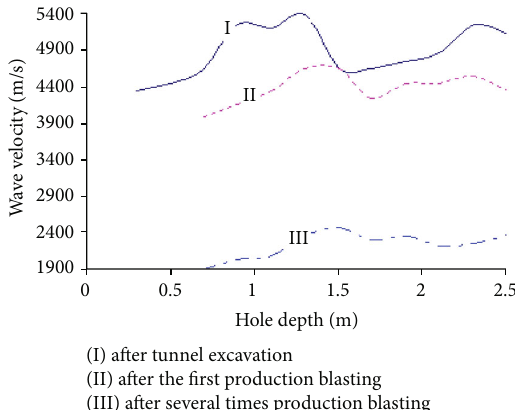
Figure 4: Corresponding curve of wave velocity and hole ’ s depth of one hole in row 3.